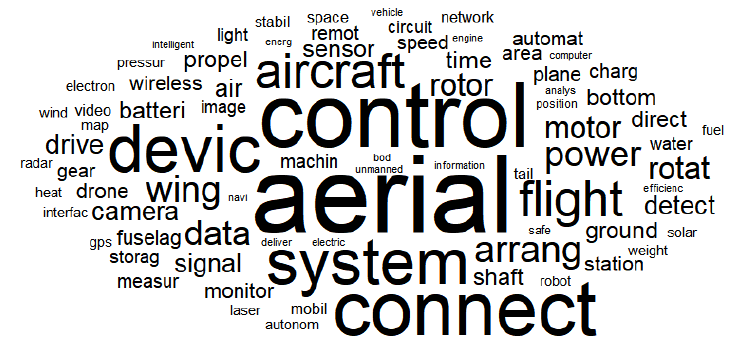
Figure 6. Word cloud of drone technology keywords.